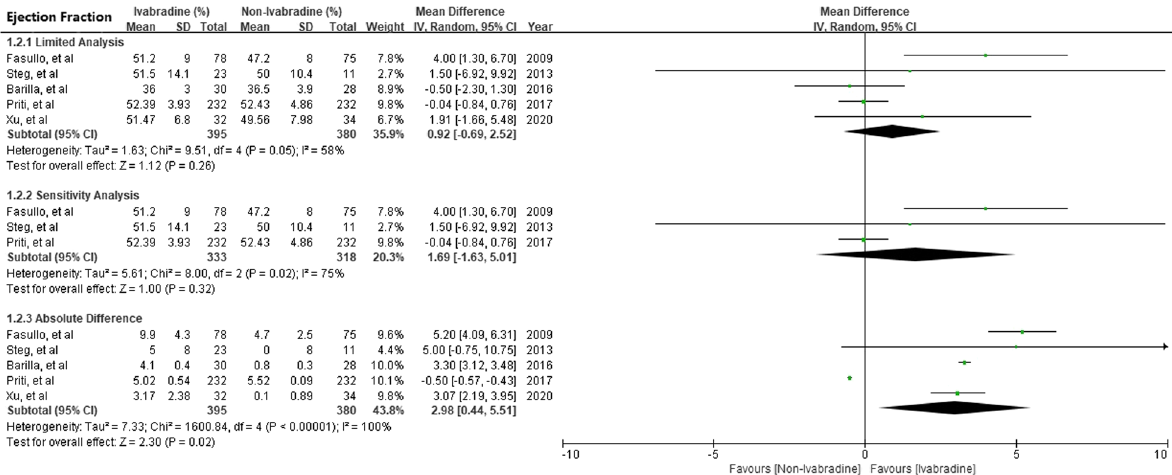
Fig. 3 Effect of Ivabradine compared with non-Ivabradine group in LV ejection